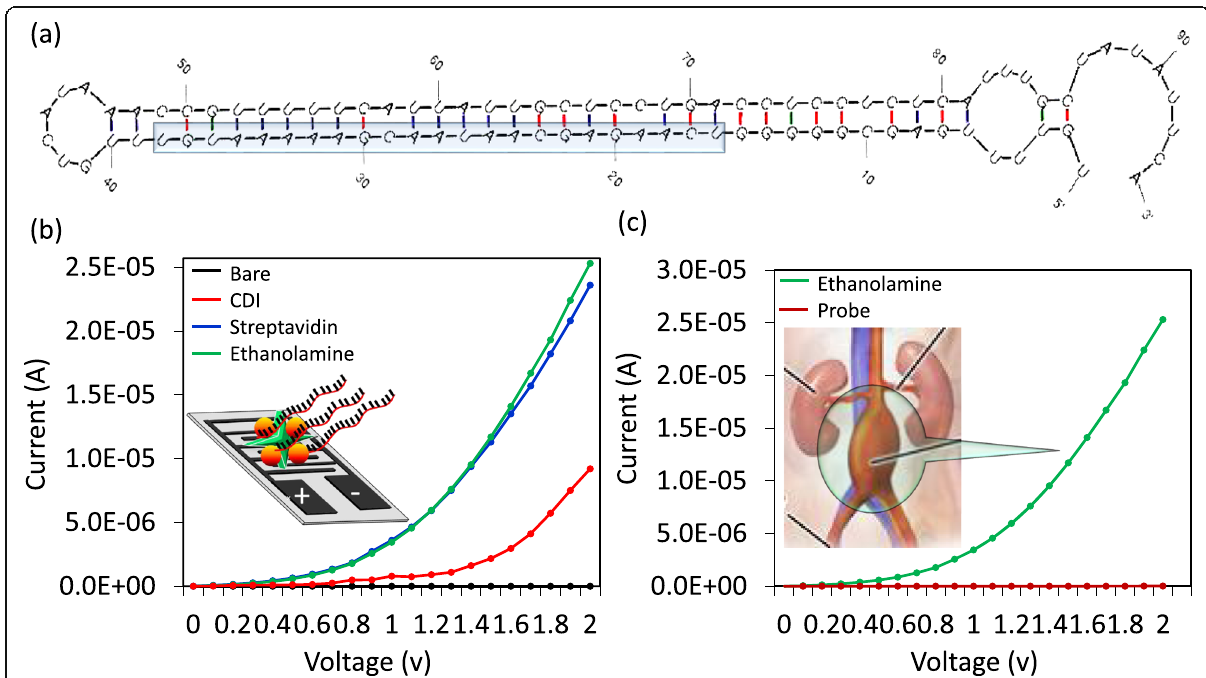
Fig. 3 a Predicted secondary structure of miRNA-335-5p. The full-length miRNA-335-5p is displayed with the stem and loop regions. The selected target region for the interactive analysis is indicated. b I-V measurements on the IDE for the surface chemical and biological modifications (black circle, bare; red circle, CDI; dark blue circle, streptavidin; green circle, ethanolamine). The figure inset is shown diagrammatically. c I-V measurements on the IDE for the probe attachment. (green circle, ethanolamine; dark red circle, probe). The image for the AAA complication is shown as the figure inset